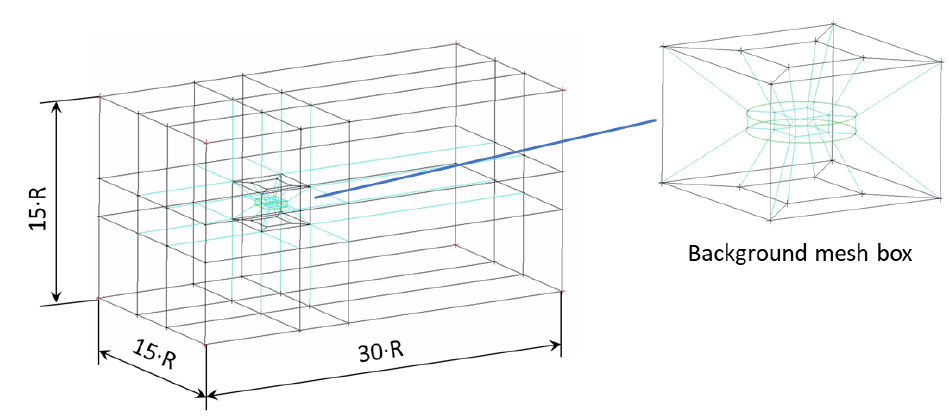
Figure 7. Size of the far-field domain with the overset background mesh in the middle of the